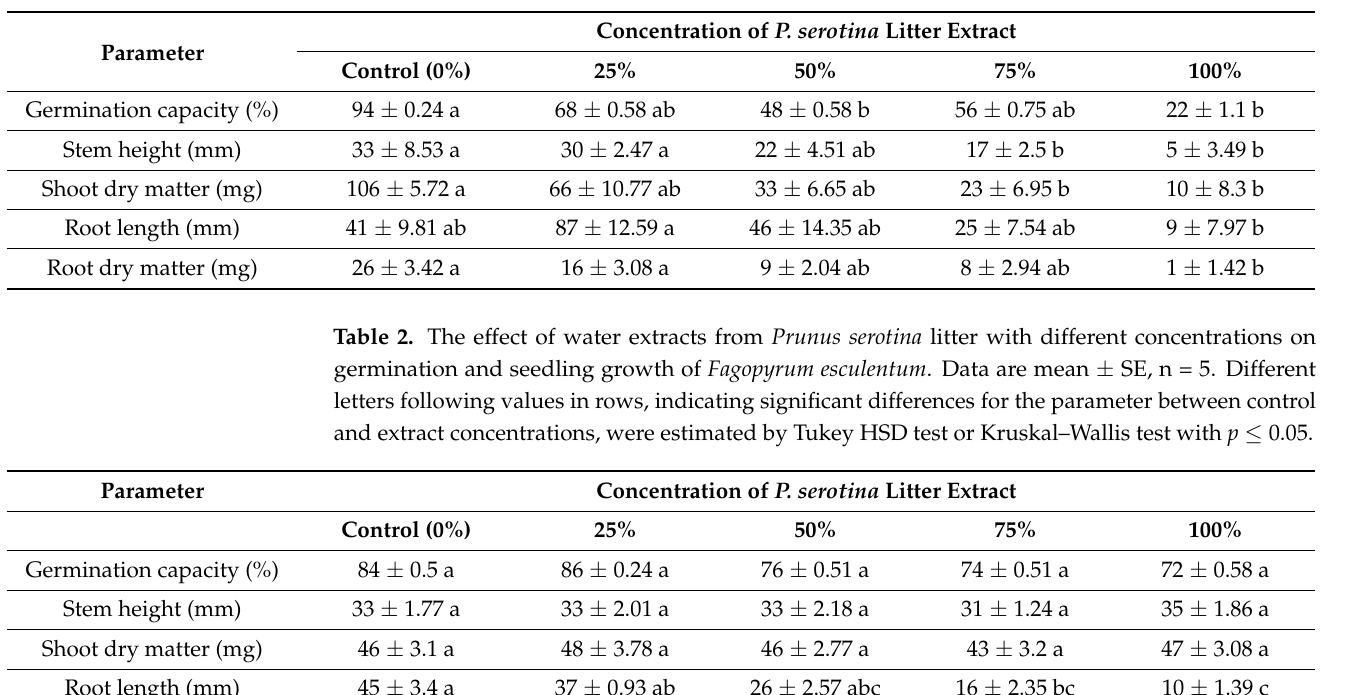
Table 1. The effect of water extracts from Prunus serotina litter with different concentrations on germination and seedling growth of Sinapis alba . Data are mean ± SE, n = 5. Different letters following values in rows, indicating significant differences for the parameter between control and extract concentrations, were estimated by Tukey HSD test or Kruskal–Wallis test with p ≤ 0.05.